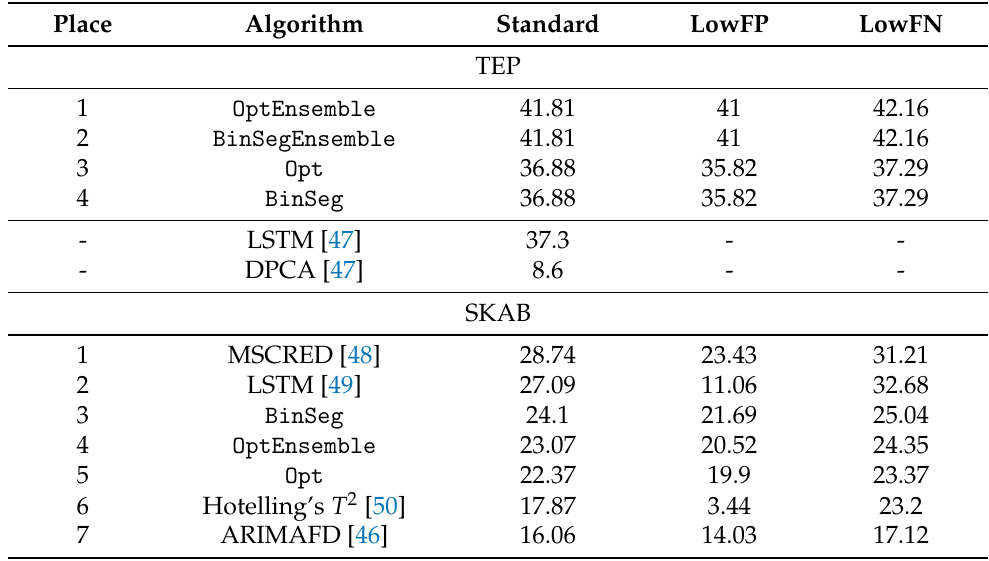
Table 4. Comparison of the CPD and CPDE procedures with SOTA changepoint detection algorithms.